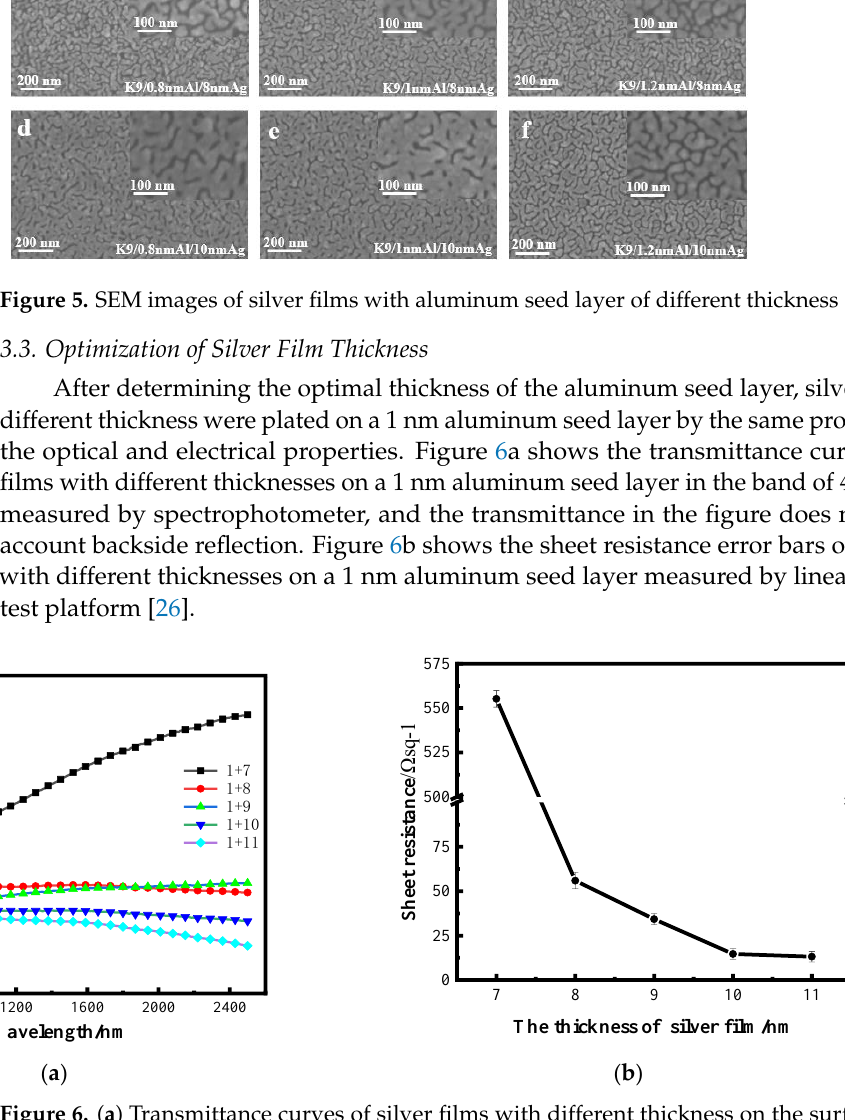
Figure 6. ( a ) Transmittance curves of silver films with different thickness on the surface of a 1 nm aluminum seed layer; ( b ) the sheet resistance curve of silver film with different thickness on an aluminum seed layer.